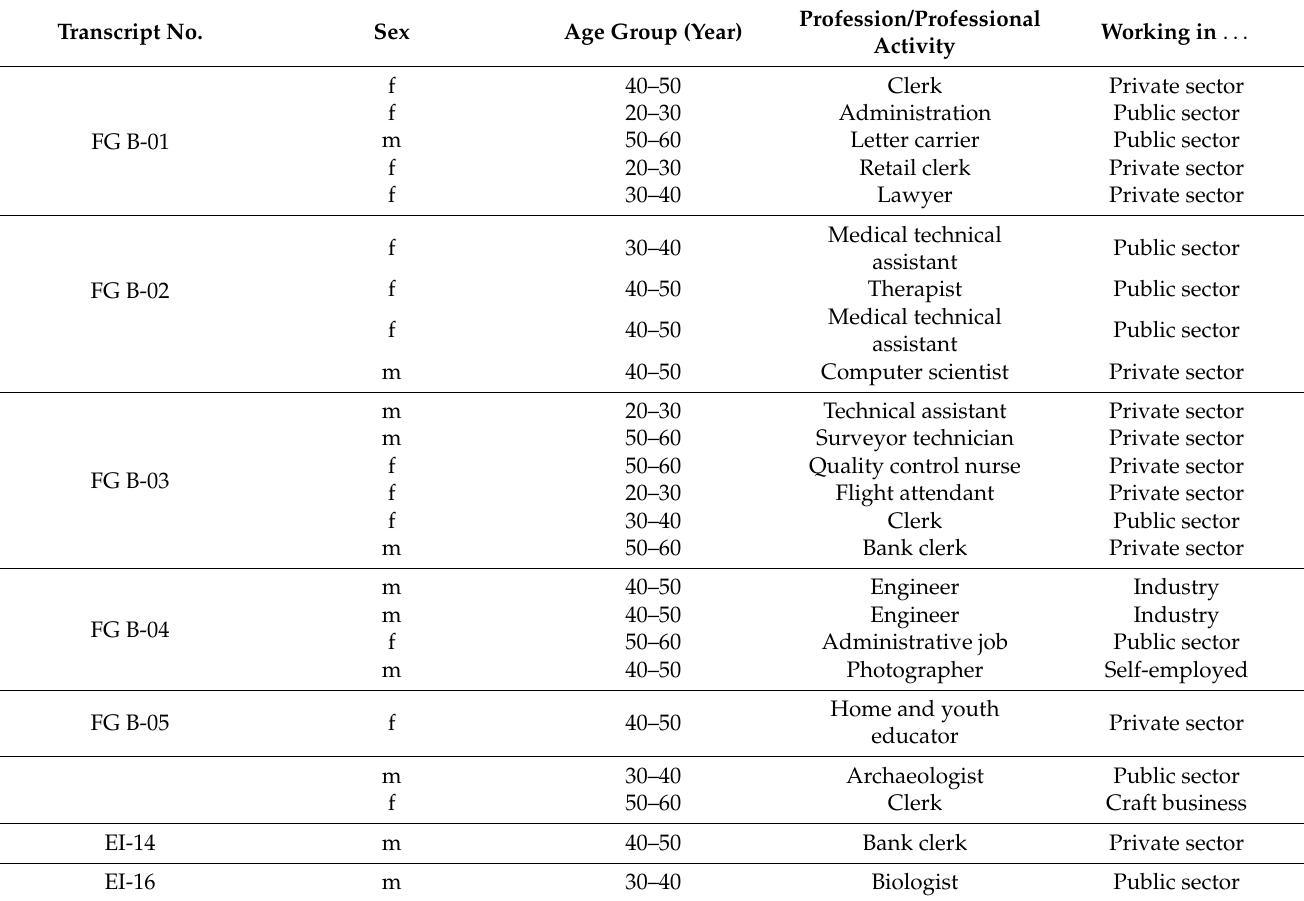
Table A5. Characteristics of Employees in focus group discussions and expert interviews.